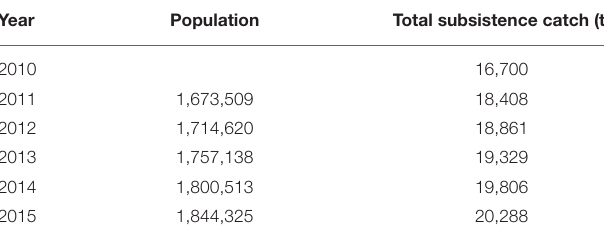
TABLE 5 | Data from subsistence has been interpolated between 2010 and